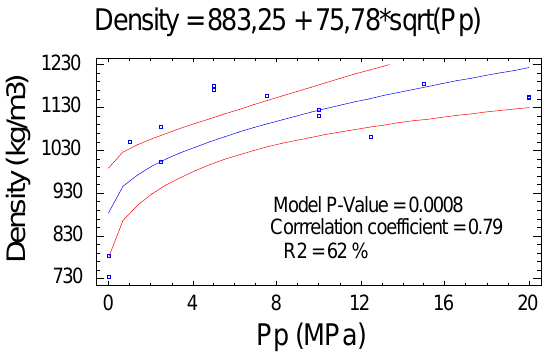
Figure 2. Series 22: Influence of pressing pressure (Pp) on density.